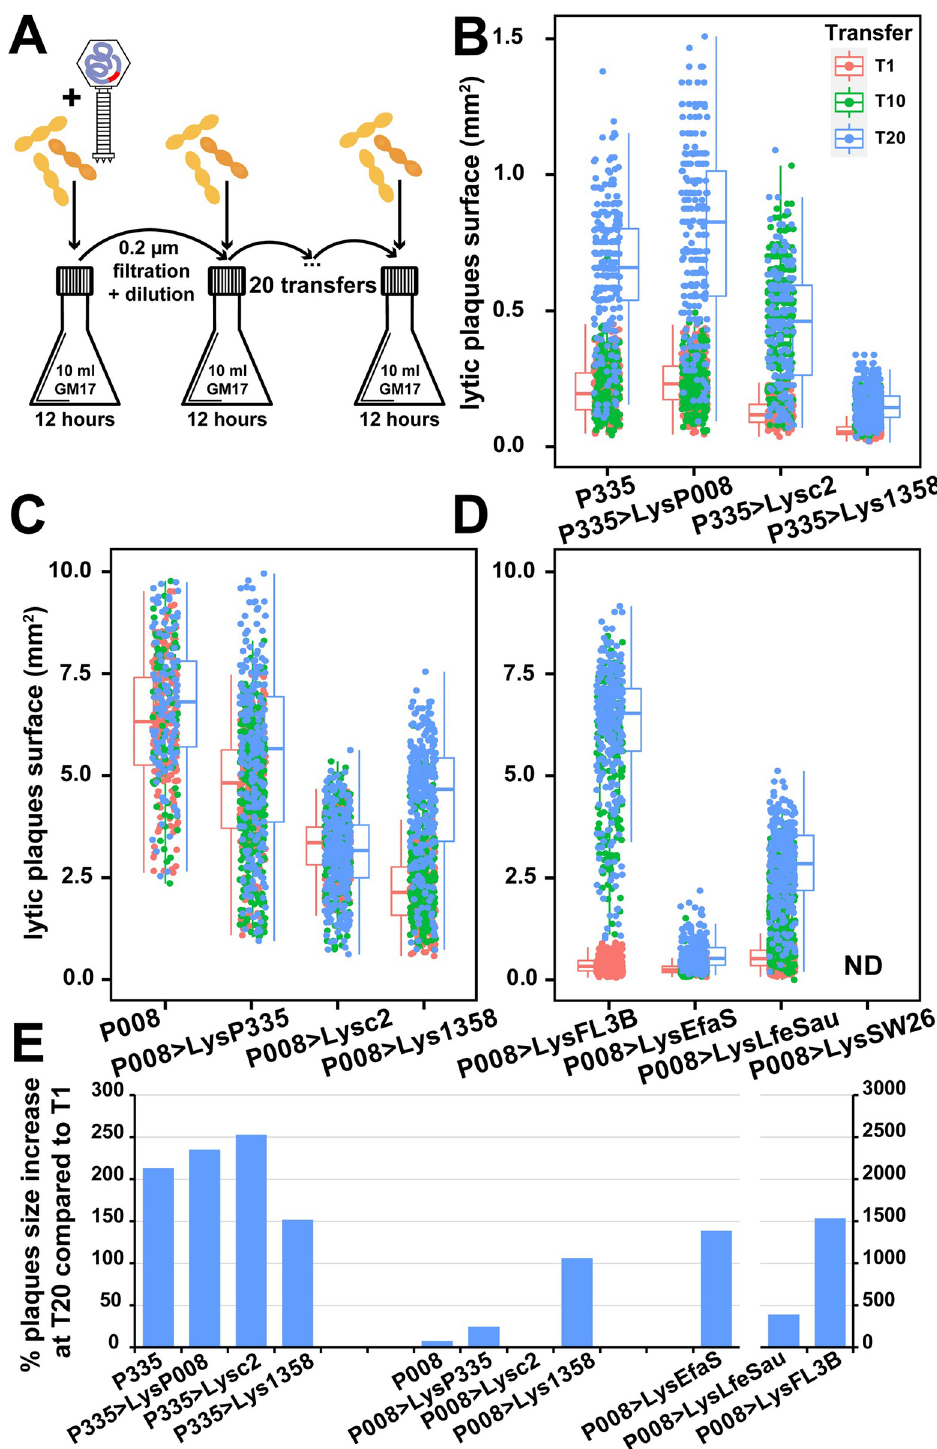
Fig 7. Experimental evolution of the phage mutants generated during the study. (A) Endolysin mutants from phages P335 and P008 were successively amplified for 20 transfers. L . lactis IL6288 cells in the exponential growth phase (OD 600nm 0.2) were infected at an initial MOI of 10. After an incubation period of 12 h at 30˚C, phage lysates were filtered and diluted before another round of amplification was started. Dilutions of 1/1,000 were used for phages P335, P335 > LysP008, P335 > Lysc2, P335 > Lys1358, P008 > LysEfaS, P008 > LysFL3B, and P008 > LysLfeSau